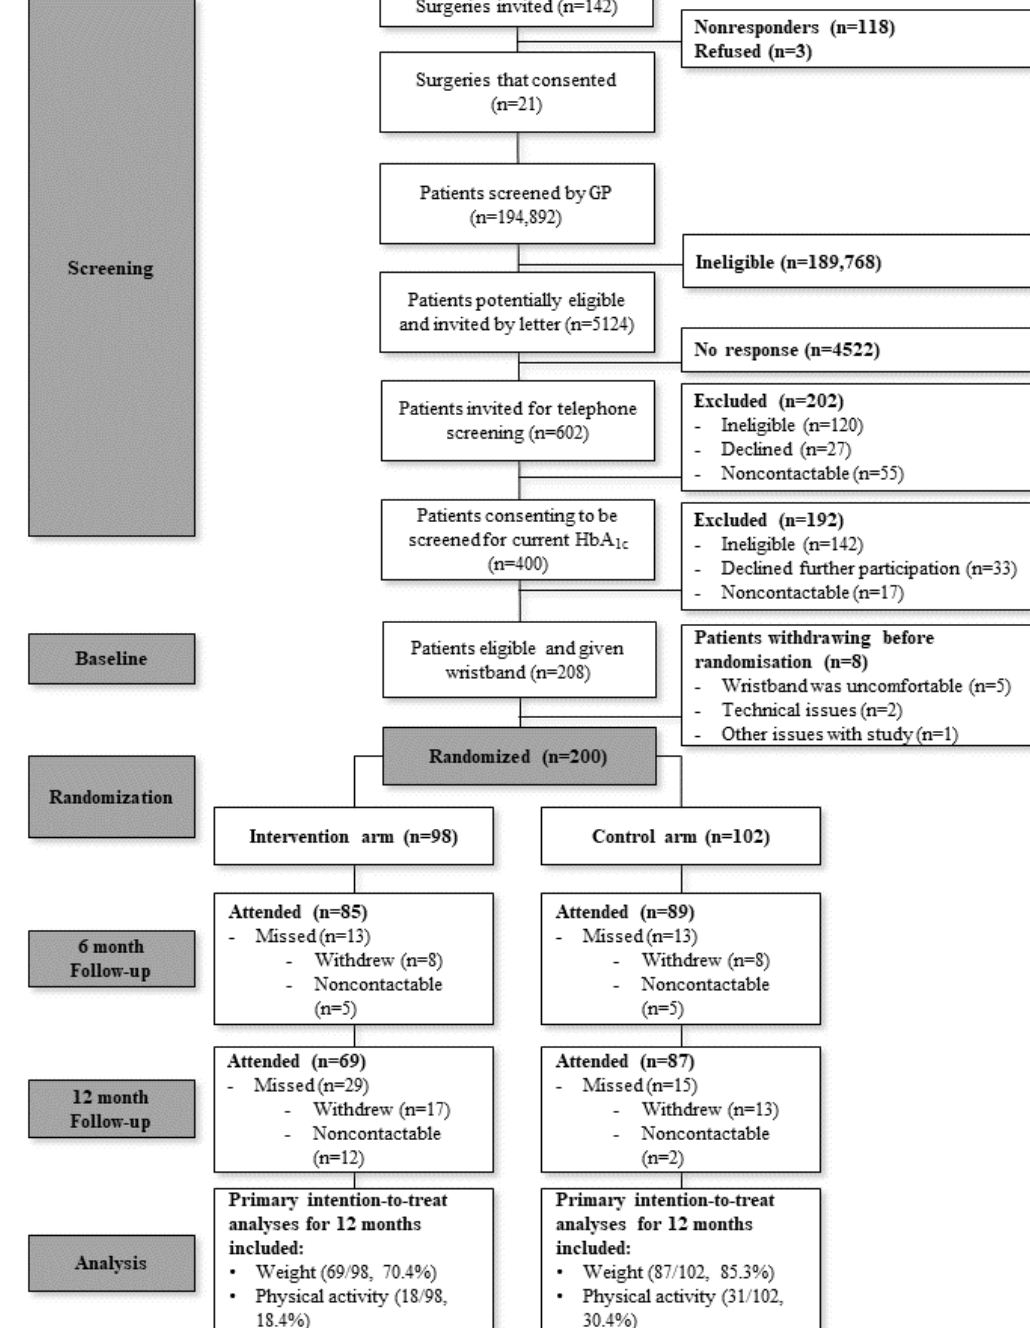
Figure 1. Participant flow